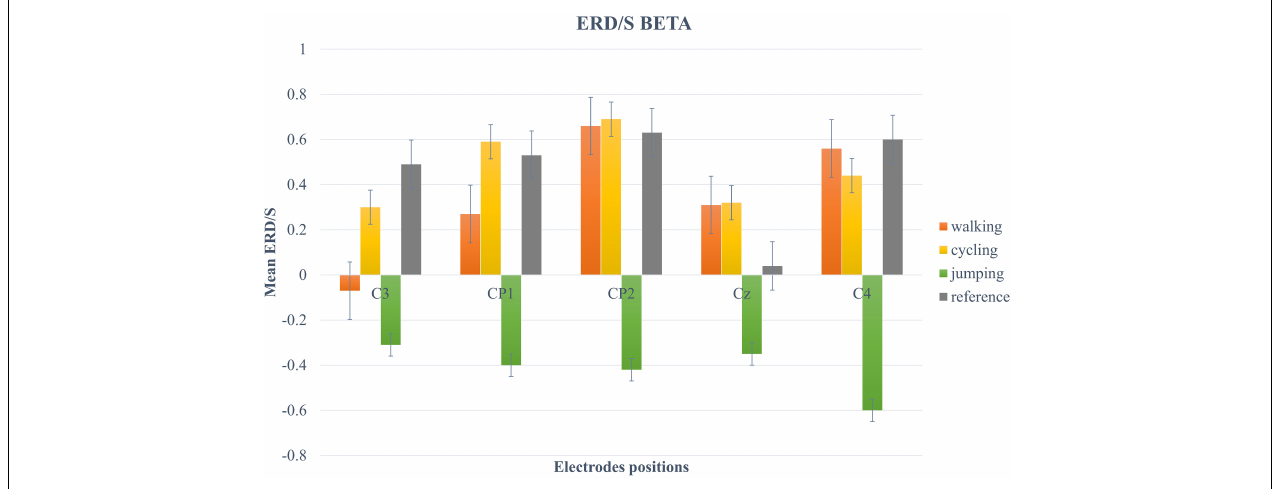
FIGURE 5 | Bar plots of mean ERD/S values of the beta-band for all conditions at electrode positions C3, CP1, CP2, Cz, C4. Error bars are SE ( ±